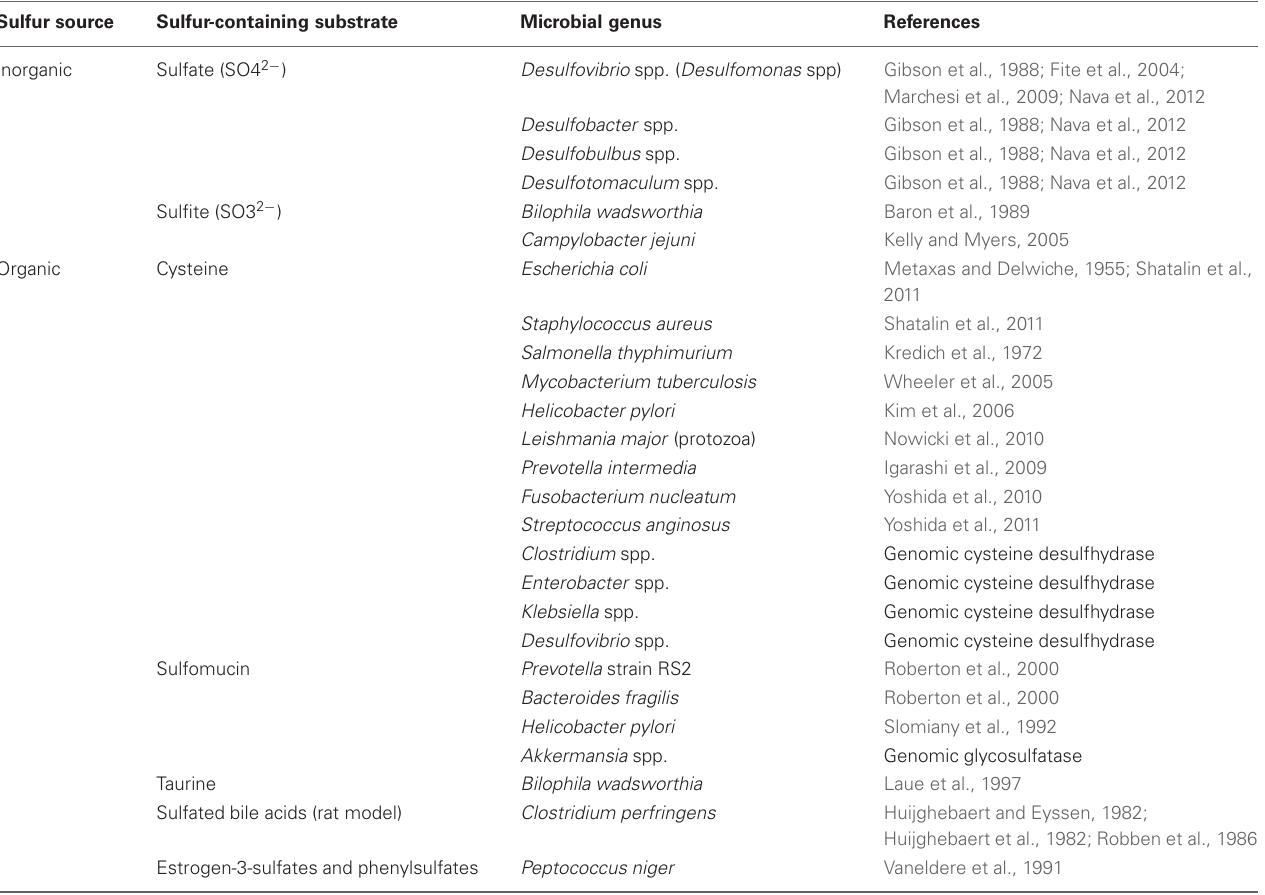
Table 1 | Microbial taxa involved in pathways of colonic sulfur